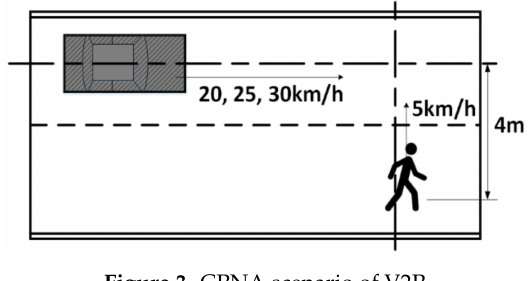
Figure 3. CPNA scenario of V2P.